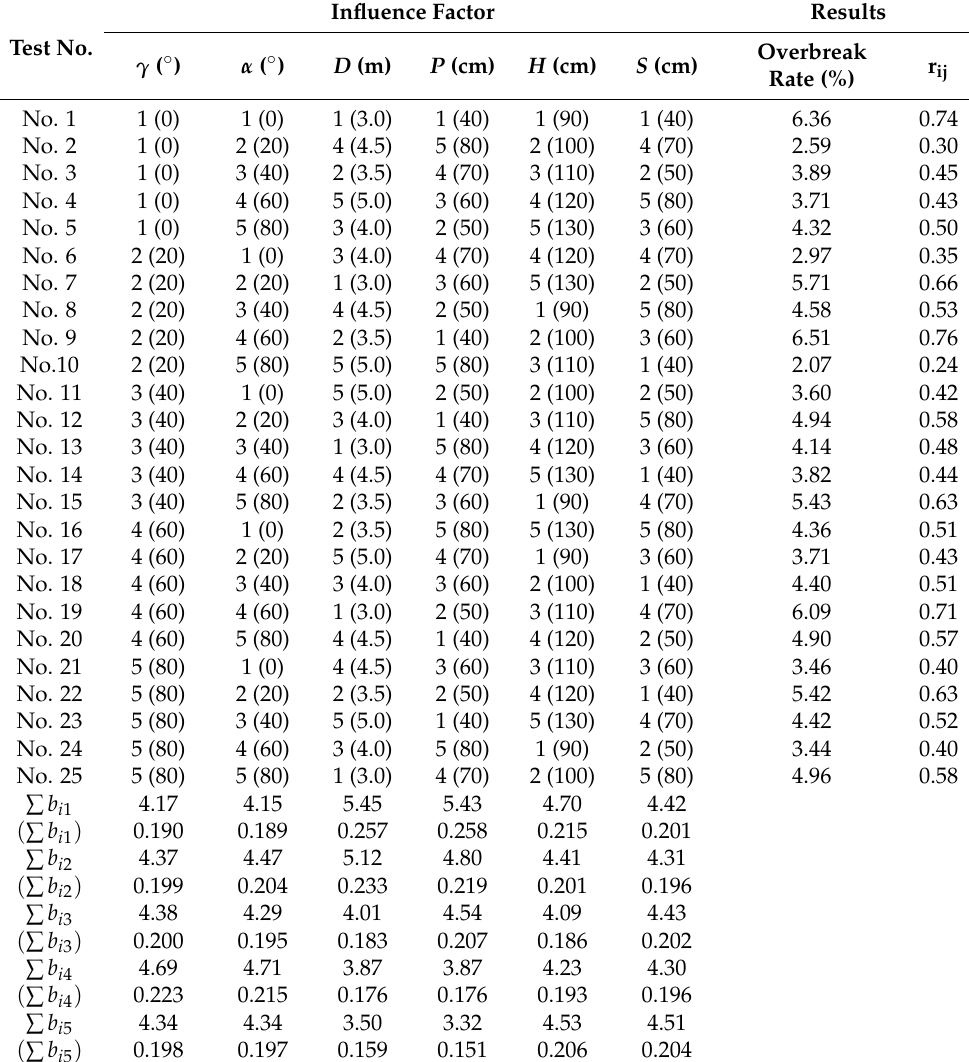
Table 9. Membership degree and fuzzy evaluation value of the overbreak rate of smooth blasting of the massive integrity structure rock